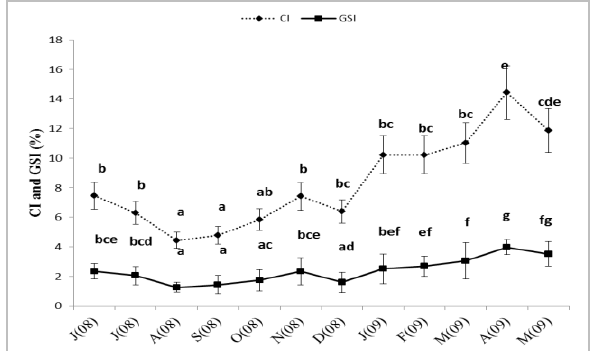
Figure 3: Seasonal variation of the condition index (CI) and gonado-somatic index (GSI) of Mactra stultorum throughout the study period.Results are given as mean ± SD, n=30 replicates each month. Different letters indicate significant monthly difference for each index (HSD Tukey’s tests, p < 0.05).